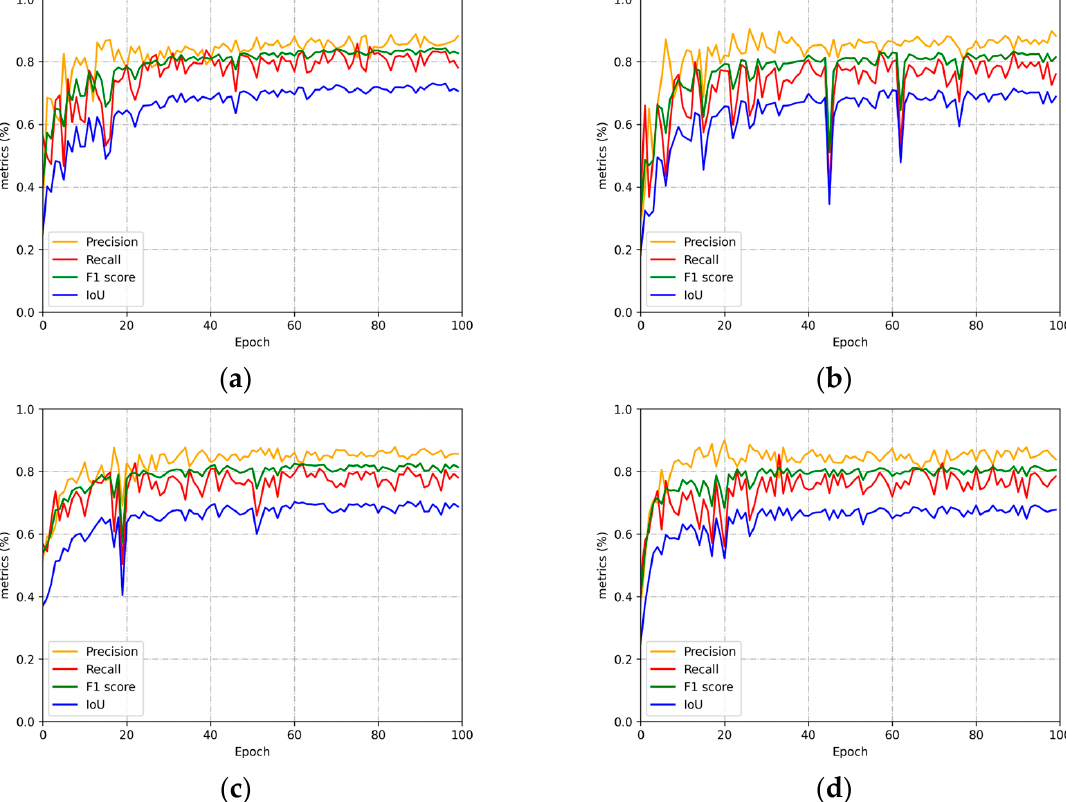
Figure 6. The metrics Precision, Recall, IoU, and F1 score as obtained from FPN for different backbones: ( a ) vgg16, ( b ) resnet152, ( c ) densenet201, ( d ) inceptionv3.